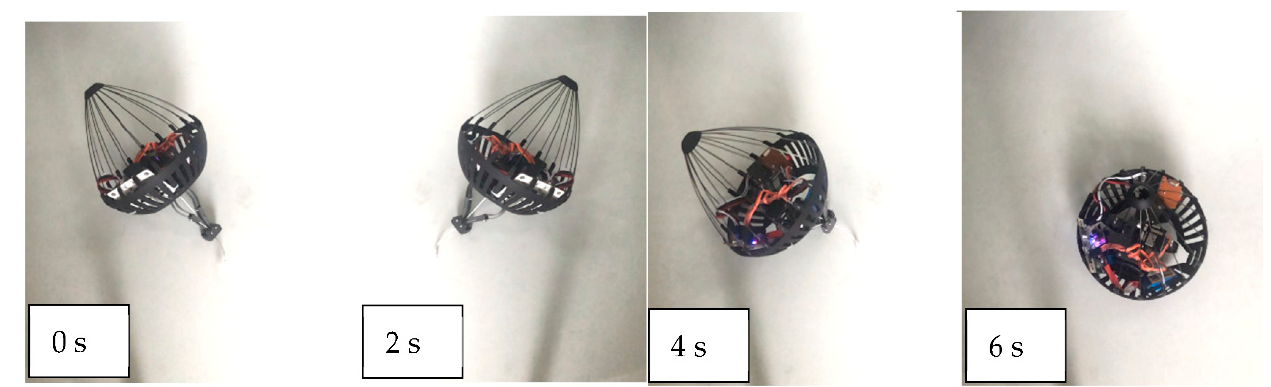
Figure 9. The robot’s passive righting process. The four images are from six frames in the video.